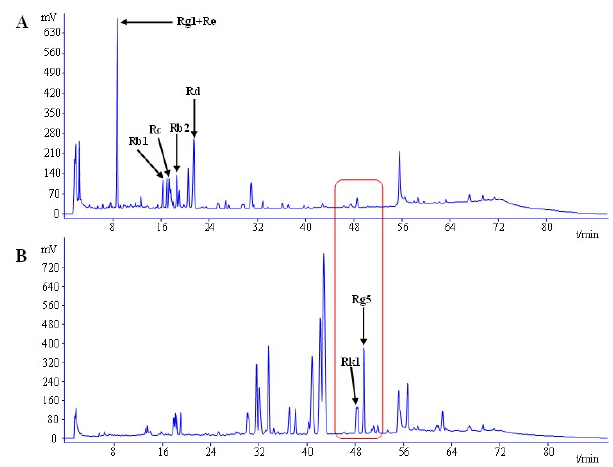
Figure 2. HPLC chromatograms of: GSLS ( A ); and steamed GSLS ( B ).